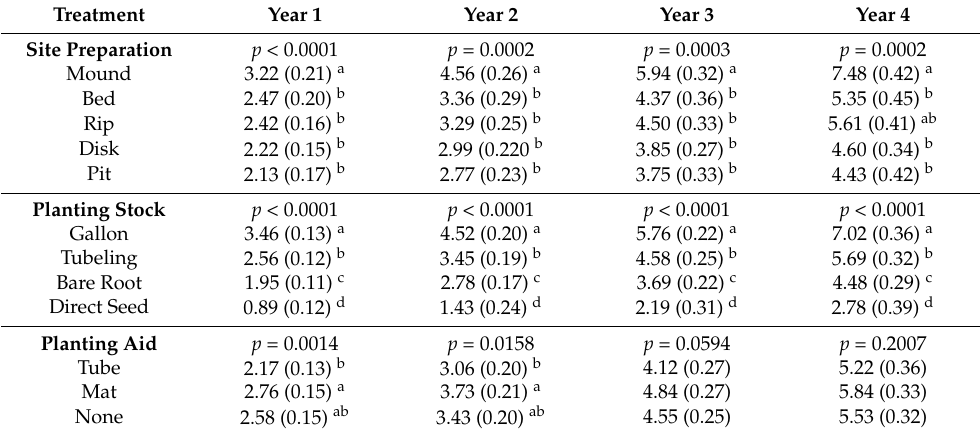
Table 3. Average groundline diameter (cm) (SE) for American sycamore in the Virginia Piedmont by site preparation, planting stock type, and planting aid. Values with different letters indicate statistically significant differences according to Tukey’s post hoc HSD ( p < 0.05). Bolded text indicates treatment category.